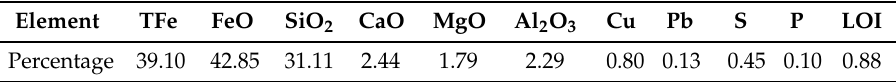
Table 1. Chemical compositions of copper slag (wt.